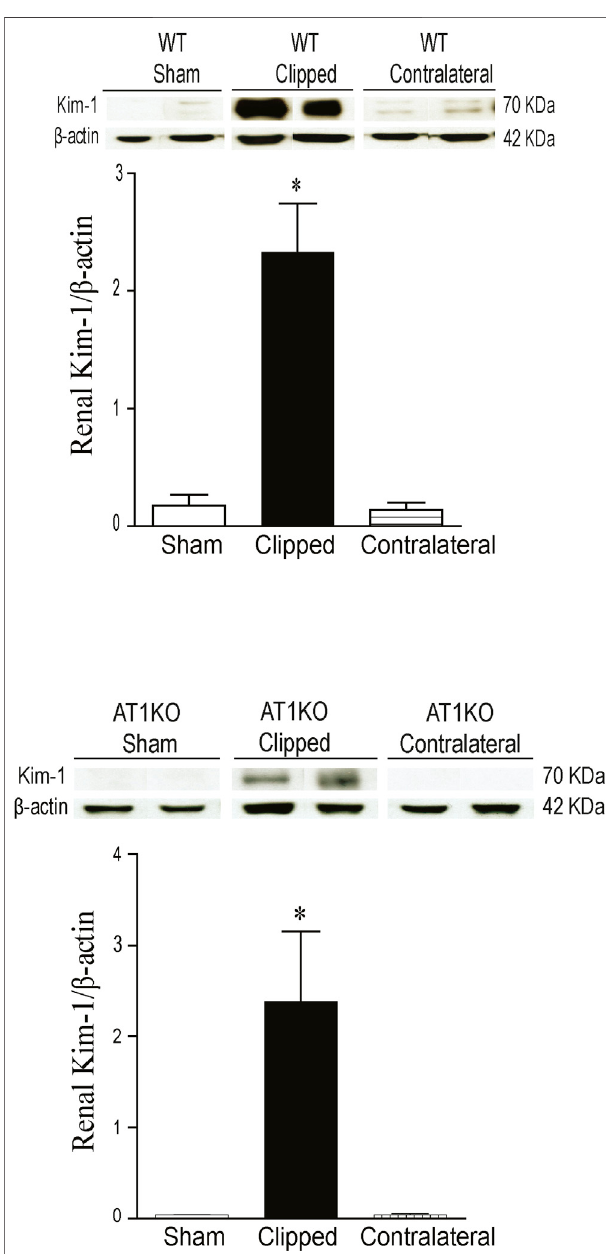
FIGURE 6 | Effectofrenovascular hypertension onrenalKIM-1expression in WT and AT1KO mice after 2 weeks of 2K1C Goldblatt surgery. (A) Renal KIM-1 protein expression in WT sham, clipped kidney and contralateral kidney. (B) Renal KIM-1 protein expression in AT1KO sham, clipped kidney and contralateral kidney. In each individual experiment, samples were loaded randomly in four gels. Two Immunoreactive bands from each group corresponding to KIM-1were appropriatelycroppedandsplicedasarepresentativeoftheresult.One-wayANOVA showed a signi fi cant increase of renal KIM-1 expression in WT and AT1KO clipped kidney compared to sham and contralateral (* p < 0.001 vs. Sham). Data are represented as mean ± SEM, (n (cid:2) 6).